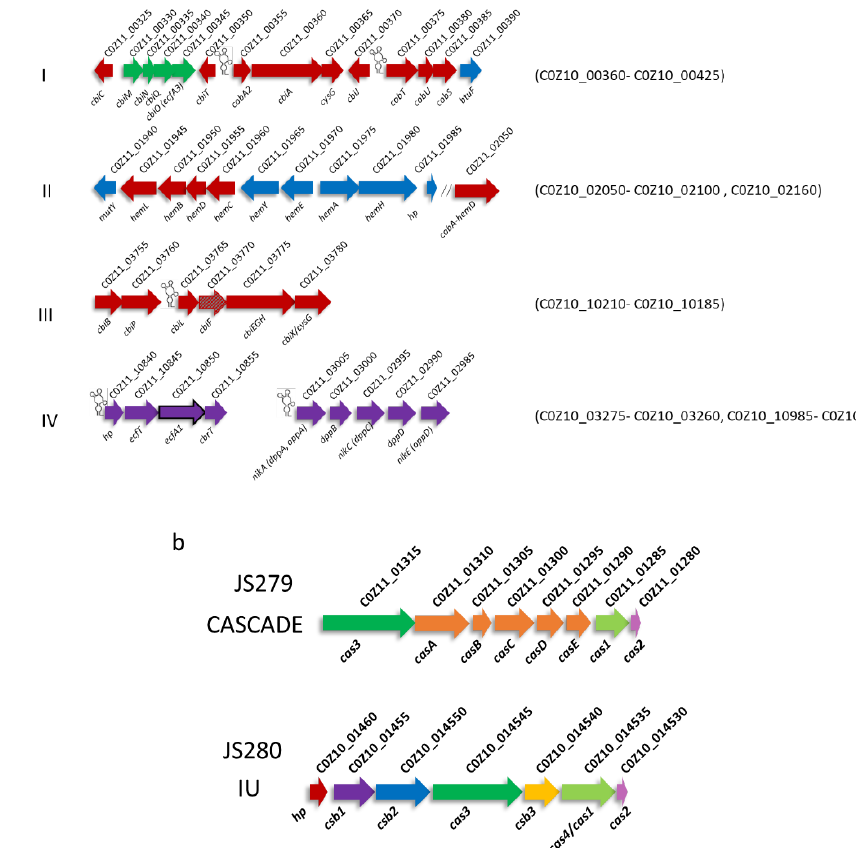
Figure 4. Further characterization of strains JS279 and JS280. ( a ) The four gene clusters of the B 12 biosynthetic genes identified in strain JS279. Genes directly involved in B 12 biosynthesis are marked in red. The cobalt transporter genes are marked in green, while the genes involved in the production of porphyrin are marked in blue. B 12 -riboswitch-controlled putative B 12 (C0Z11_10840-C0Z11_10855) and nickel (C0Z11_02985-C0Z11_03005) transporters are marked in purple. Loci of the corresponding gene clusters in strain JS280 are indicated in brackets. The gene C0Z11_10850 in the putative B 12 transporter, annotated in JS280 as a pseudogene (C0Z10_03265), is outlined. ( b ) CRISPR-Cas systems Type IE (or CASCADE) in strain JS279, similar to the one previously reported in P. freudenreichii as well as a novel Type IU in strain JS280, similar to those previously reported in P. freudenreichii as well as A. virtanenii . 3.3.2. Mobile Elements and Defence Mechanisms Analysis with CRISPRfinder identified 14 potential CRISPR arrays, two of which are associated with a complete CRISPR-Cas system (Figure 4b) in each JS279 and JS280 strains. The arrays PossibleCRISPR1 and CRISPR2 of the strain JS279 share a direct repeat (DR) consensus sequence CGGATTACCCCCGCTCGCGCGGGGACGAC. CRISPR2 consists of 76 spacers located between 280463–285125 and is associated with a complete CRISPR-Cas type IE system (Figure 4a). CRISPR1 consists of two spacers and is located directly upstream of the CRISPR2 array (279029–279180). CRISPR1 and CRISPR2 are separated by three genes coding for hypothetical proteins, each with